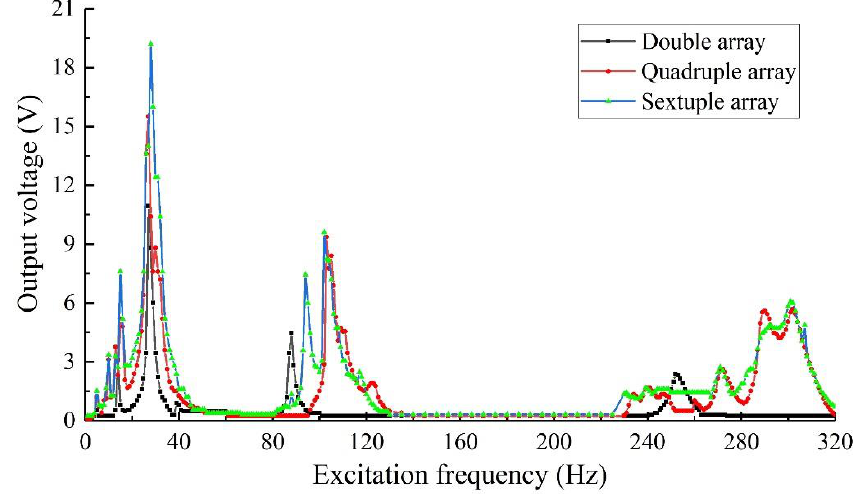
Figure 19. Sextuple array structure installation.